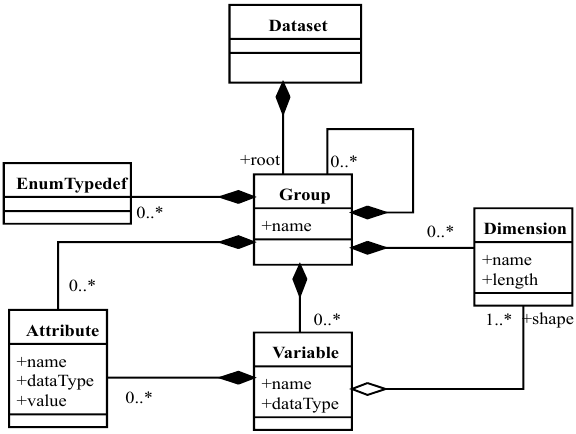
Figure 5. Main structures of the UNIDATA common data model